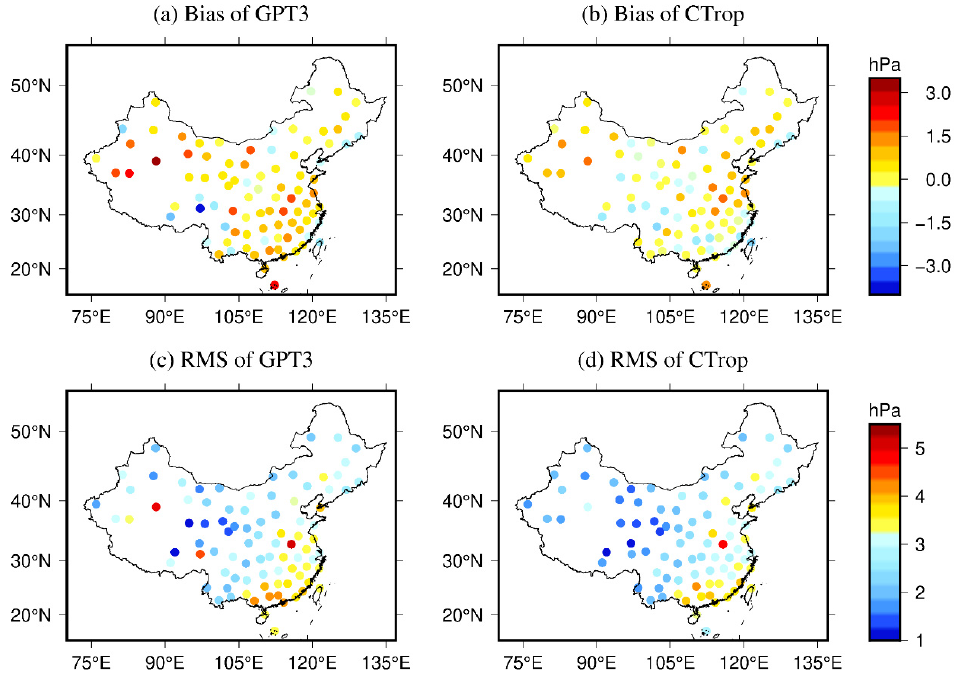
Figure 8. Distribution of the performance of water vapor pressure at each radiosonde site in 2017 by the CTrop and GPT3 models: ( a ) Bias of GPT3; ( b ) Bias of CTrop; ( c ) RMS of GPT3; ( d ) RMS of CTrop.